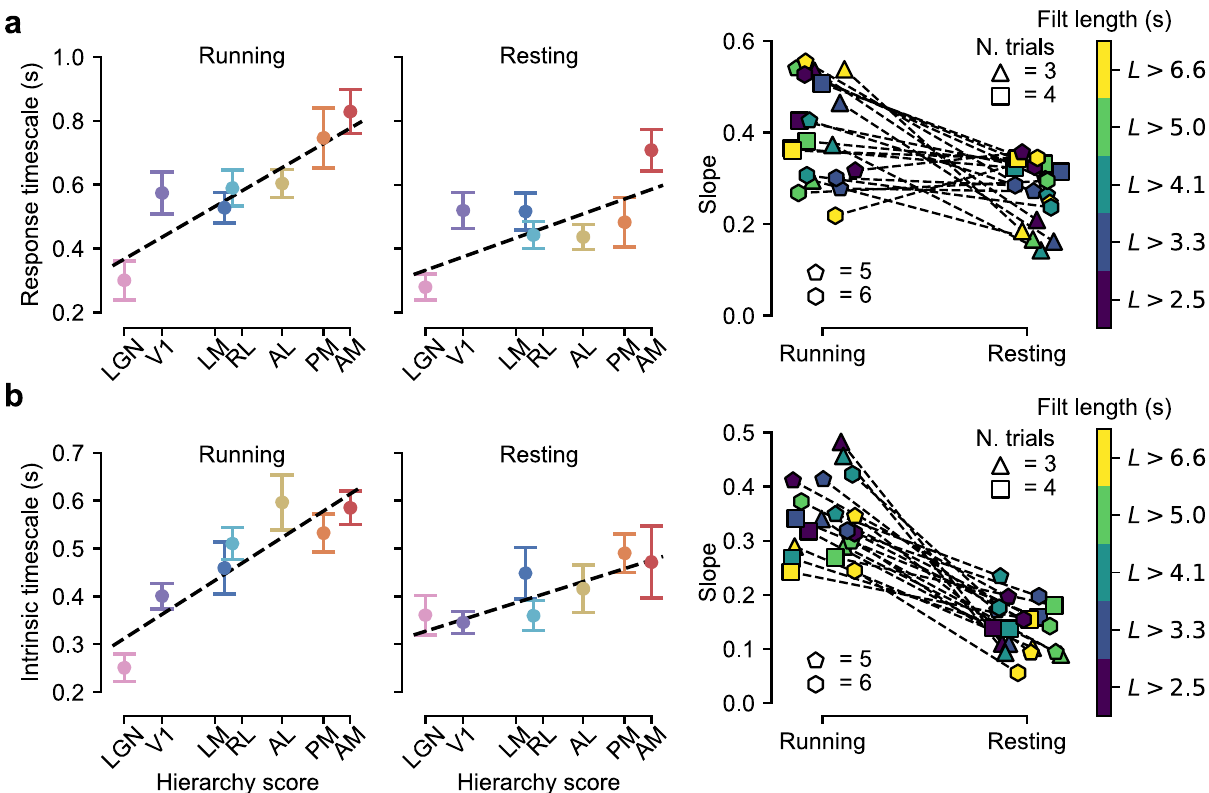
Fig. 8 State dependence of response and intrinsic timescales. a Left, center: examples of the hierarchical trends of response timescales as a function of the anatomical hierarchy score for the particular choice of the parameters N t = 5 and L = 4.125 s (see main text) in the running (left) and resting (center) state. Data points are averages over 11 epochs of running and resting states. Error bars are s.e.m. The dashed black lines are error-weighted linear regressions. Right: scatter plot reporting the angular coef fi cients of the linear regressions for all the 4 × 5 combinations of the parameters N t and L , in the case of the running and resting states (the dashed lines connect matching choices of N t and L ). The shape of the markers codes for N t , the color for L (see key). b Left, center: same as in a (left, center) but for the intrinsic timescales and for the choice of the parameters N t = 6 and L = 2.475s. Data points are averages over 11 epochs of running and resting states. Right: same as in a (right) but for the intrinsic timescales. Source data are provided as Source Data fi